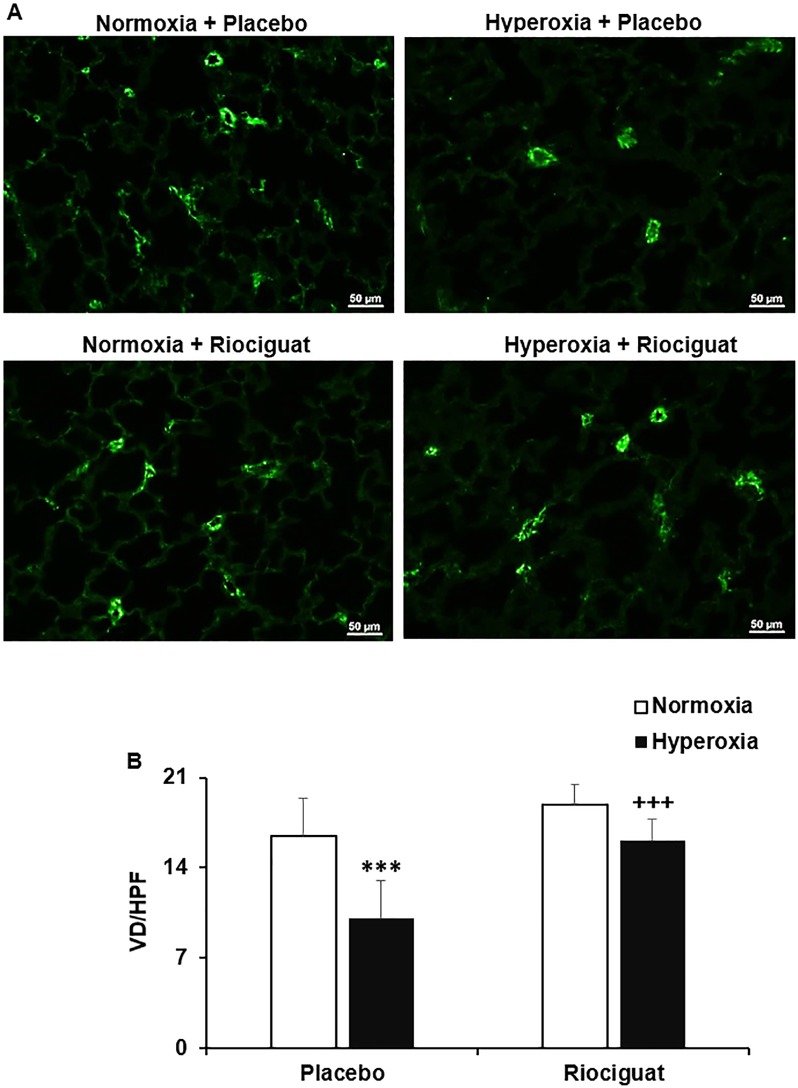
Riociguat prevents hyperoxia-ablated vascular development.(A) Immunofluorescence staining for von-Willebrand factor (vWF) (green signal). Vascular density (VD) was determined by counting vWF-positive vessels (<50 μm in diameter) on 10 random high-power field (HPF) images from each lung section. (B) Hyperoxia exposure in the presence of placebo significantly decreased VD as compared with normoxia group. Administration of riociguat increased VD in hyperoxia exposed lungs. ***P < 0.001 compared with normoxia; +++P < 0.001 compared with hyperoxia + placebo (n = 6/group). Scale bar: 50 μm.